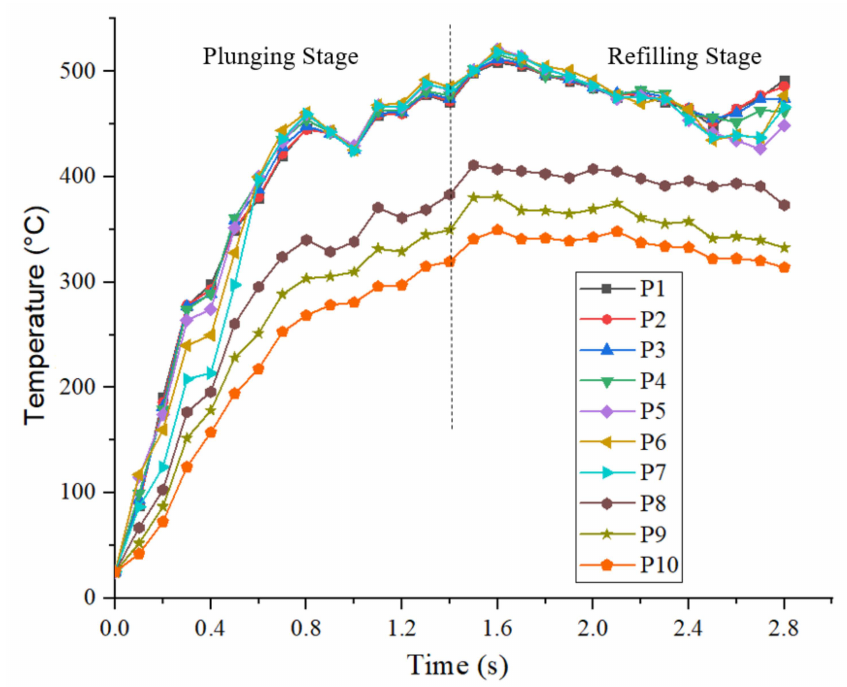
Figure 16. Temperatures at the point locations (P1–P10), located on top of the workpiece, see Figure